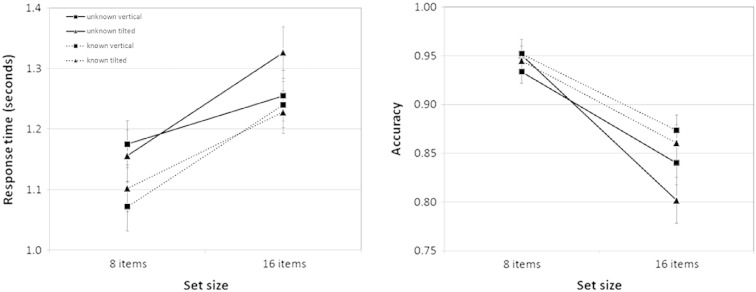
Response times and accuracy when target location was known (dotted lines) and unknown (solid lines), for vertical (squares) and tilted (triangles) displays. Error bars show standard errors.